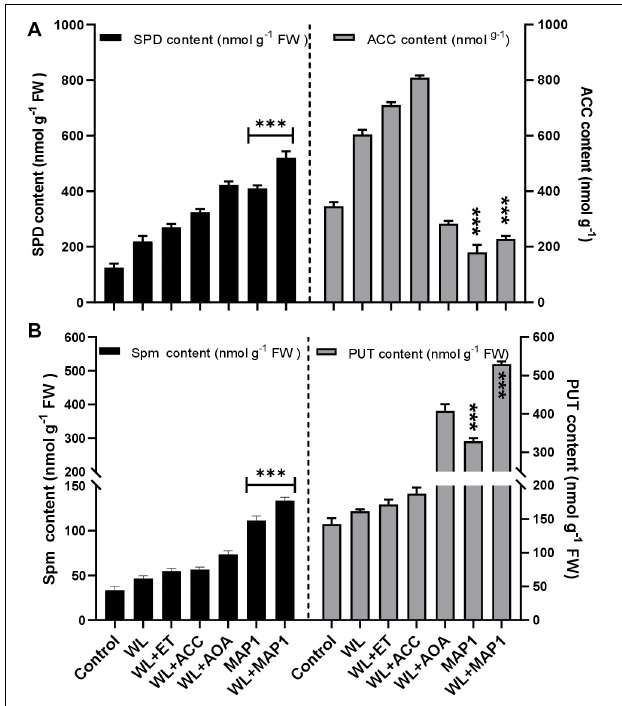
FIGURE 8 | Effect of WS on free polyamines and ACC content. (A) Spermidine (left axis) and ACC content (right axis). (B) Spermine (left axis) and putrescine (right axis) in wheat plants with and without MAP1 inoculation. Quantitative data represent means ± SD of three independent experiments and at least 10 technical replicates each. The asterisks indicate a significant difference compared to untreated control ( ∗∗∗ p ≤ 0.05).